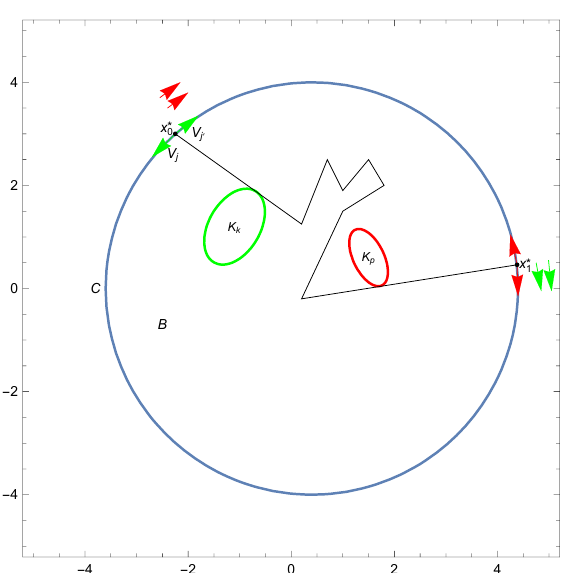
Figure 3. A linear bitangent (proof of Proposition 5).